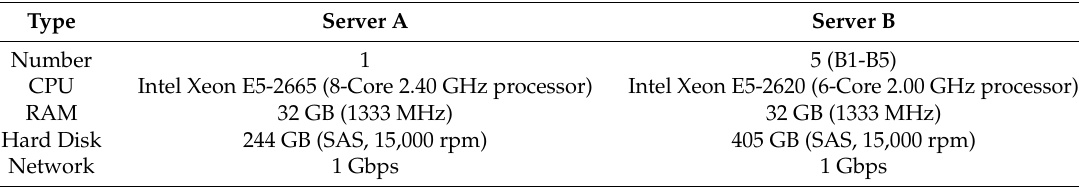
Table 3. Hardware Test